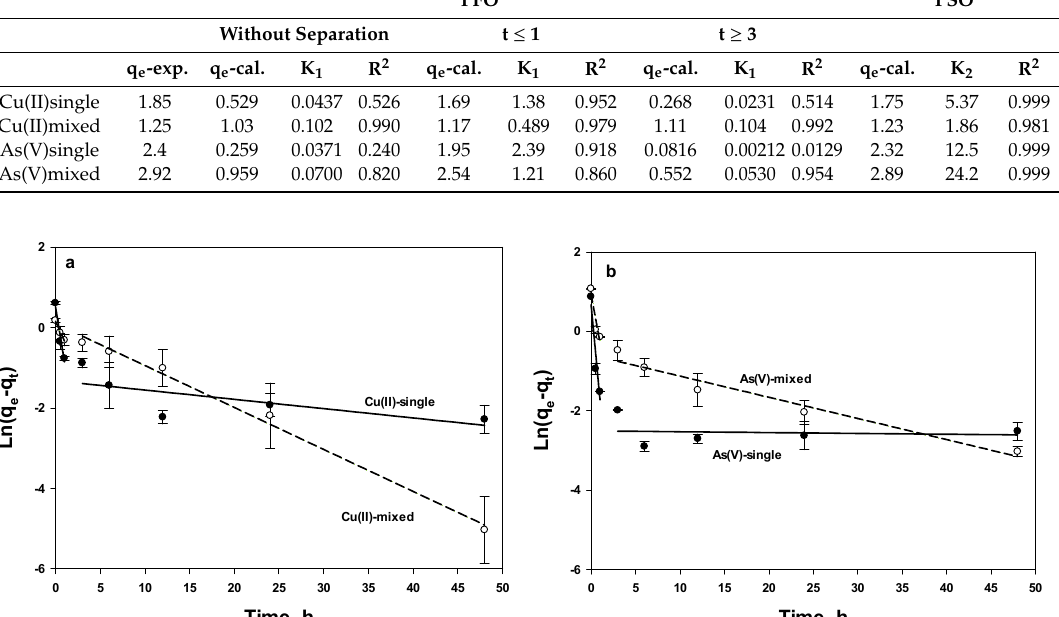
Figure 5. Linear PFO model for ( a ) Cu(II) and ( b ) As(V) with two sections. Table 2. Kinetic parameters for the linear PFO and PSO models for Cu(II) and As(V) in single and mixed solutions. PFO PSO Without Separation